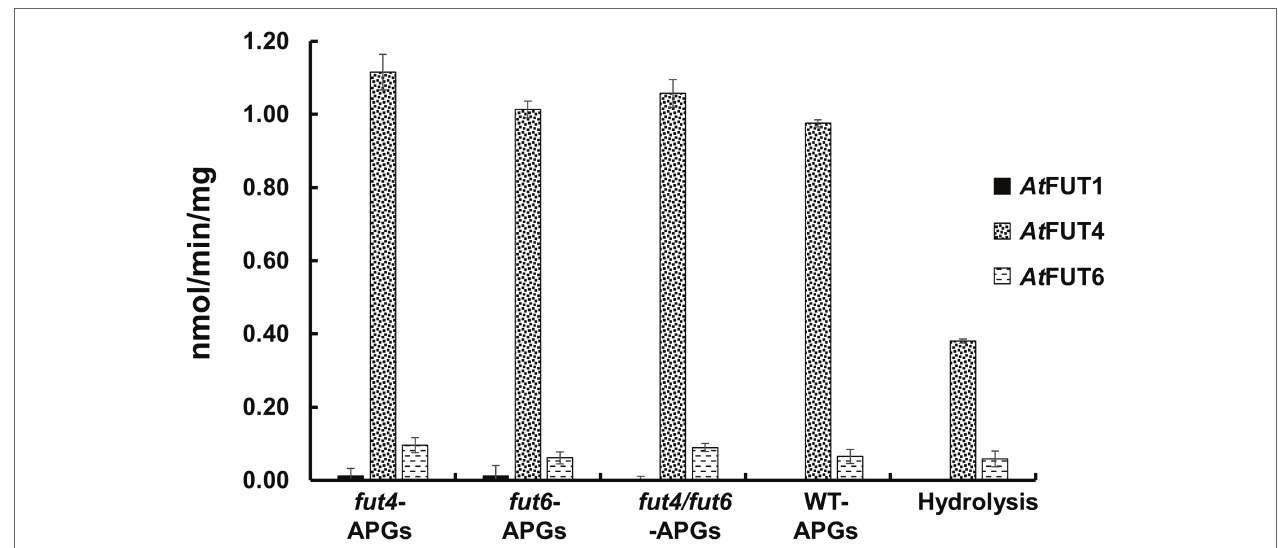
FIGURE 5 | Relative enzyme activity of GFP- At FUT1, GFP- At FUT4, and GFP- At FUT6 using AGPs extracted from vegetative tissue of wild-type (WT), fut4 , fut6 , and fut4fut6 A. thaliana mutants as acceptor substrates. Values are represented as the average of three technical replicates ±SD, and are reported in nmol/min/mg of